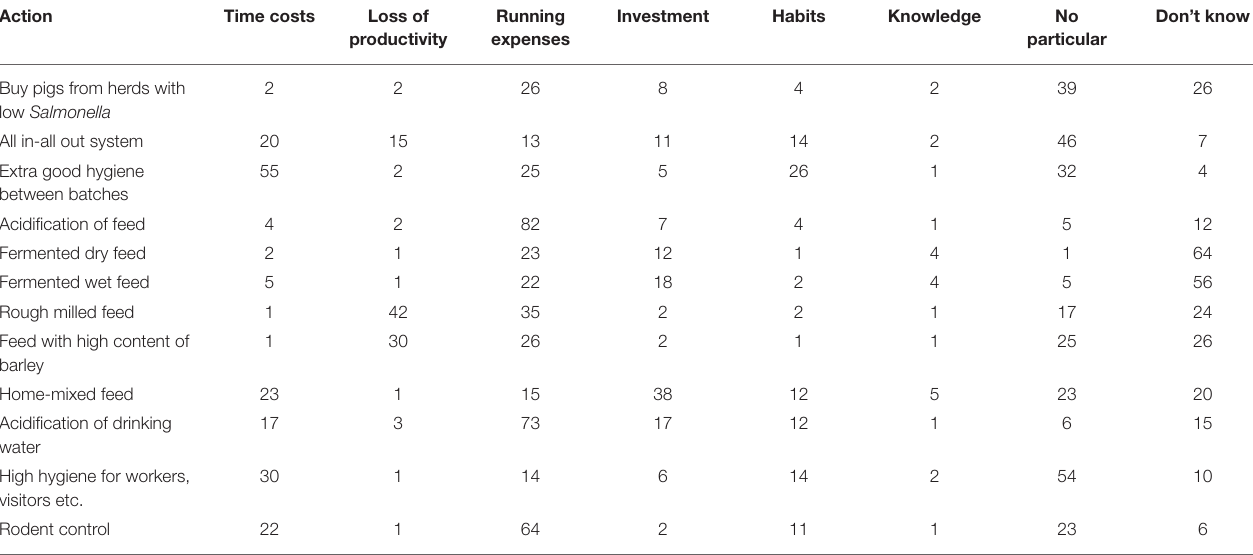
TABLE 7 | Share of farmers who associate various types of costs with the presented Salmonella reducing actions (in percent of respondents). Action Time costs Loss of